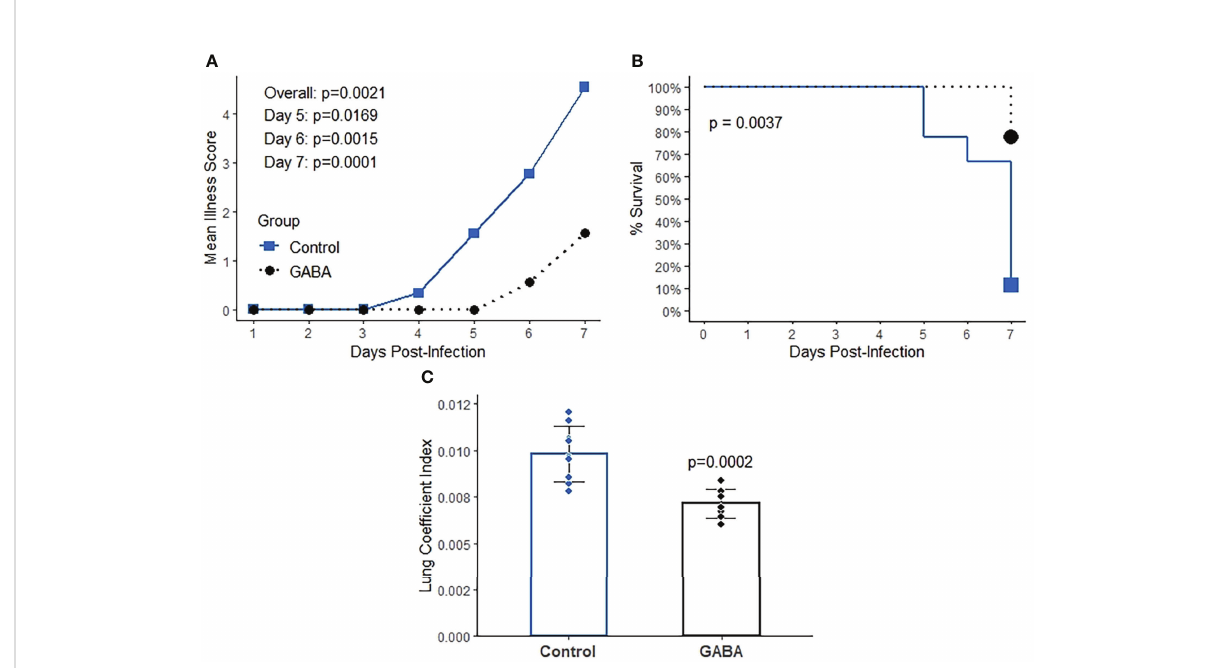
FIGURE 4 GABA treatment initiated near the peak of lung viral load has protective effects in SARS-CoV-2 infected K18-hACE2 mice. Mice were infected with SARS-CoV-2 and two days later mice received GABA through their drinking water (2 mg/mL), or were maintained on plain water for the remainder of the study. (A) Longitudinal mean illness scores. The data were analyzed by fi tting mixed-effect linear regression models with group and time as fi xed effects (to compare means), and with group, time and group by time interaction as fi xed effects (to compare slopes). Mouse ID was used as a random effect. (B) Percent surviving mice. The data were analyzed by Kaplan-Meier survival curves and the log-rank test. (C) Lung coef fi cient index. The data were analyzed by Student t-test. N=9